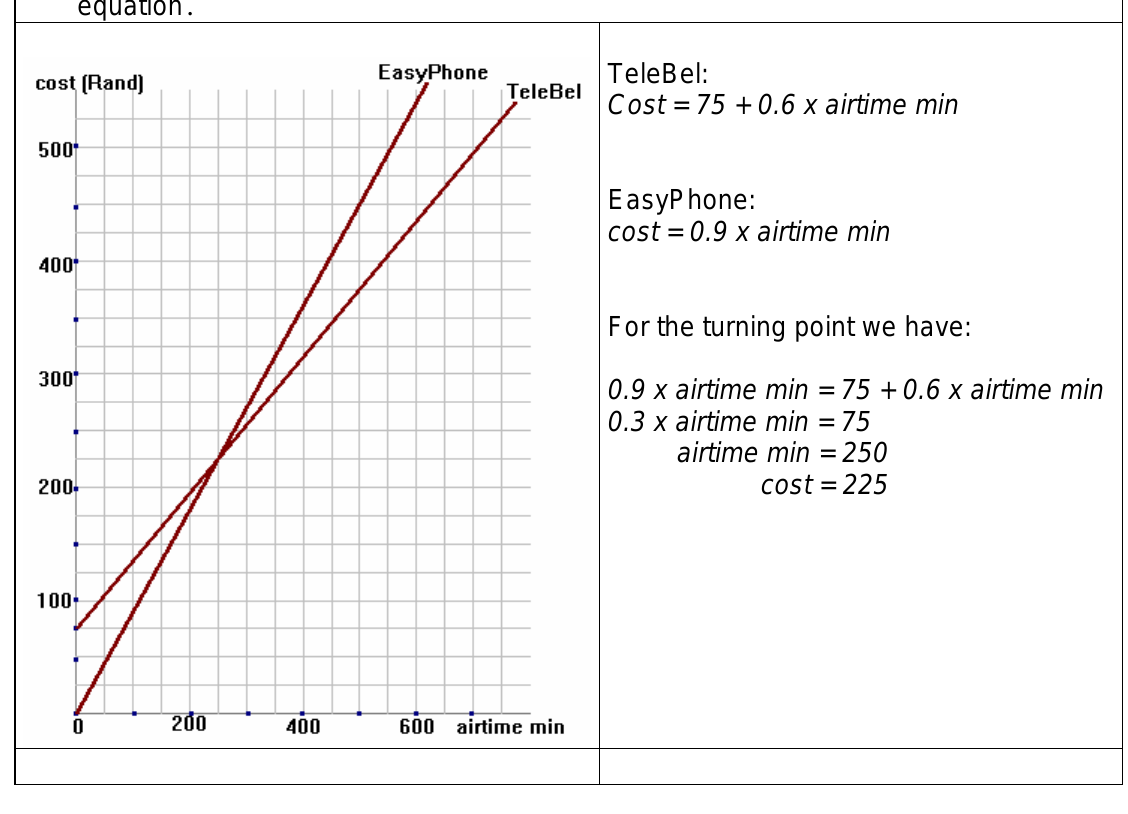
Figure 1. Comparative graph (linked to Table 2) Language of the context Mathematical language Airtime minutes on horizontal axis